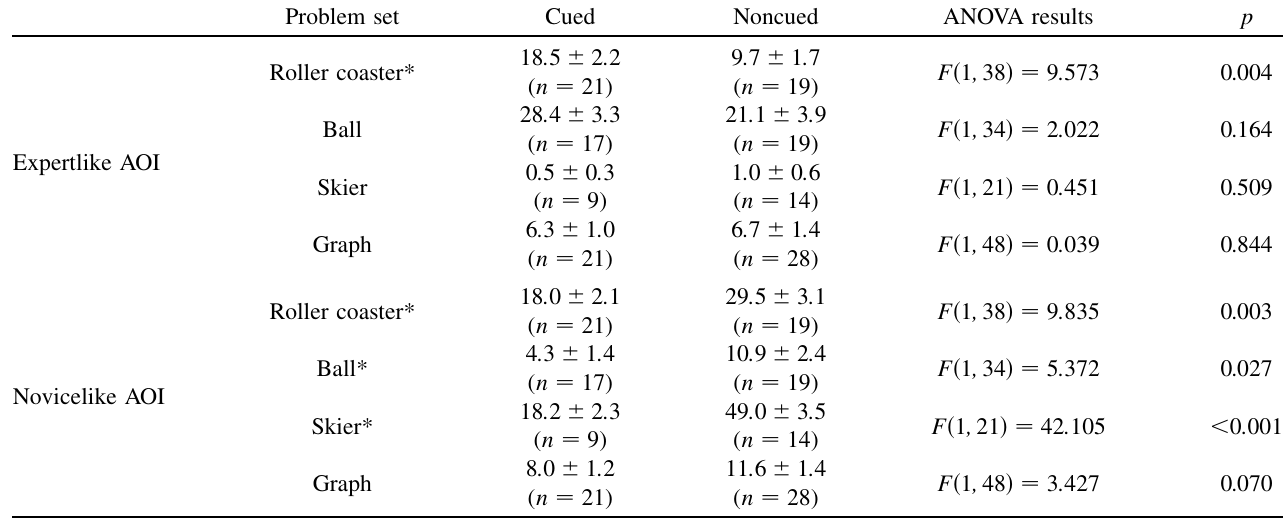
TABLE IV. Mean percentage fixation time spent ( (cid:3) standard error) on the transfer problems for expertlike and novicelike AOIs for participants in the cued and noncued